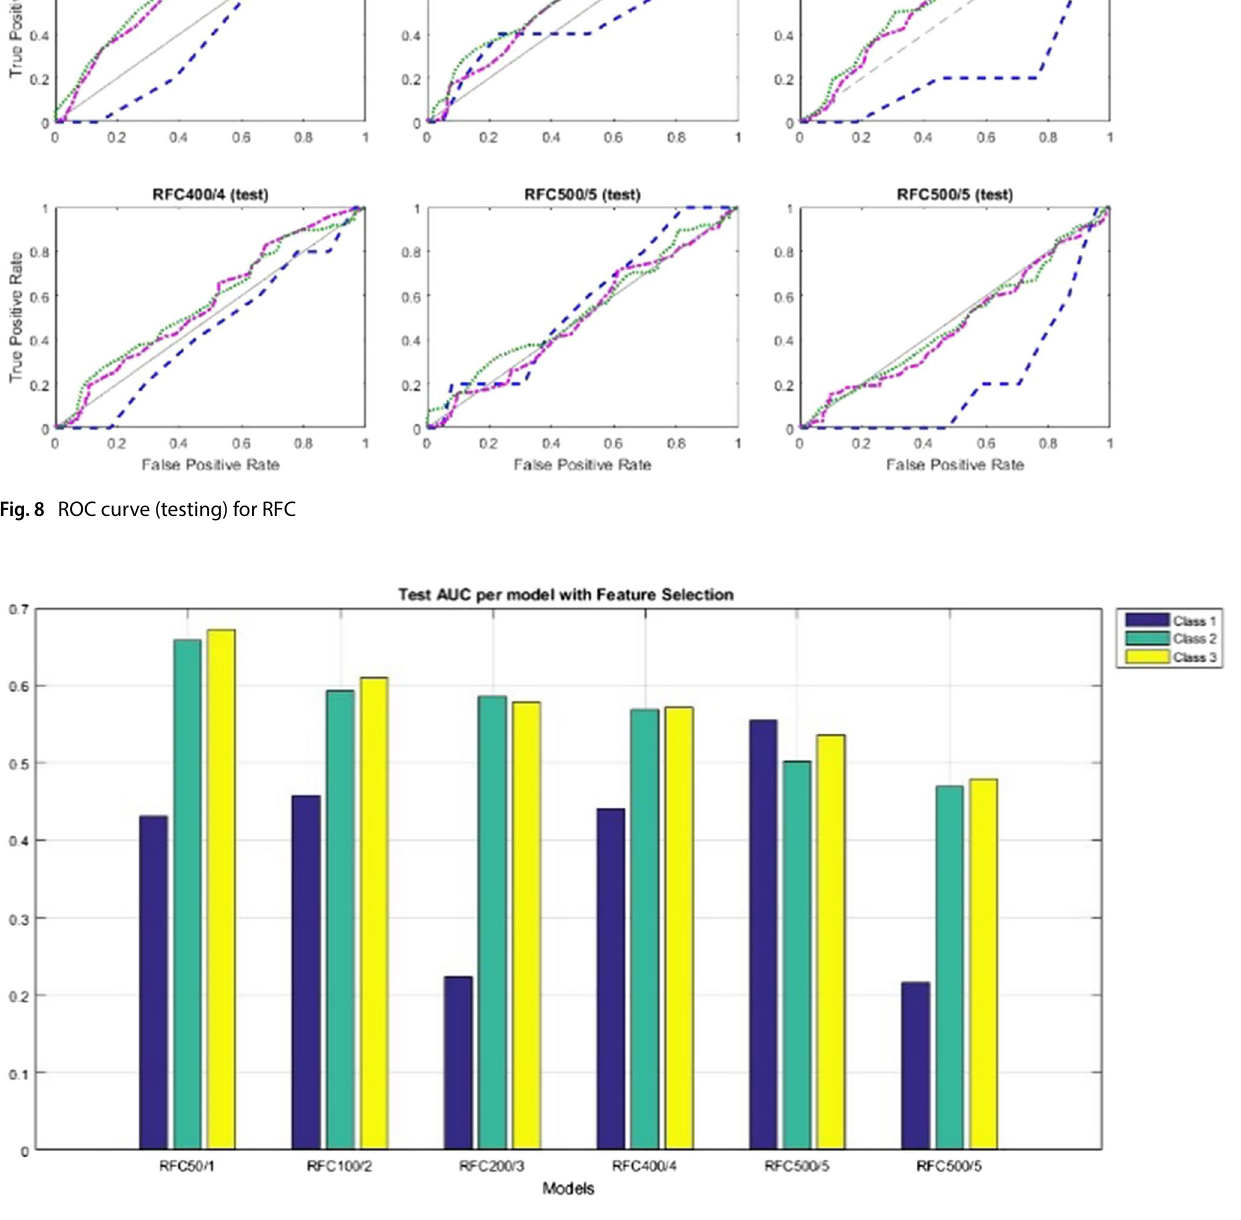
Fig. 9 AUC (testing) for